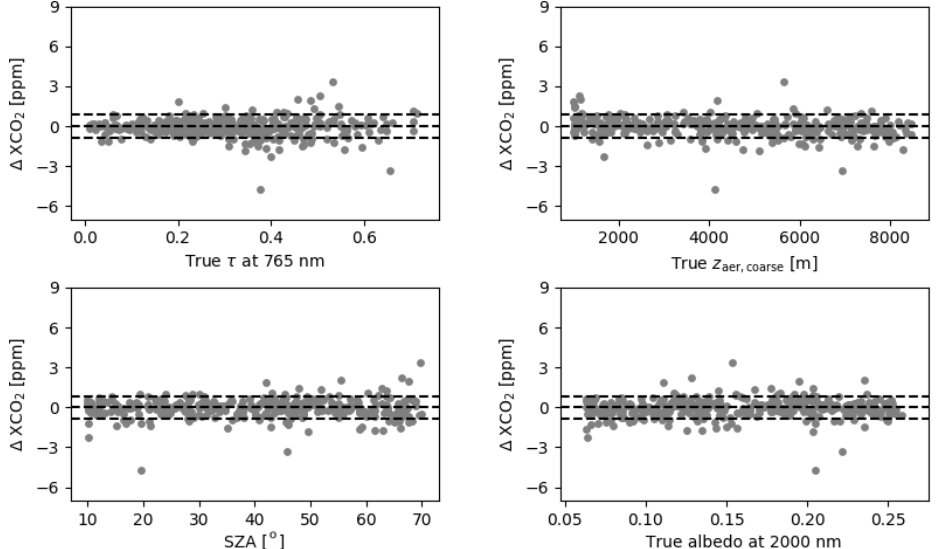
Figure 7. Residual XCO 2 from the converged joint retrievals using spectrometer and MAP-mod measurements, shown as a function of total aerosol optical depth τ , coarse-mode aerosol height, SZA, and albedo. The input spectra are generated according to the ensemble of synthetic scenes (Sect. 4). The three dashed horizontal lines indicate (cid:49) XCO 2 at − 0 . 86, 0, and